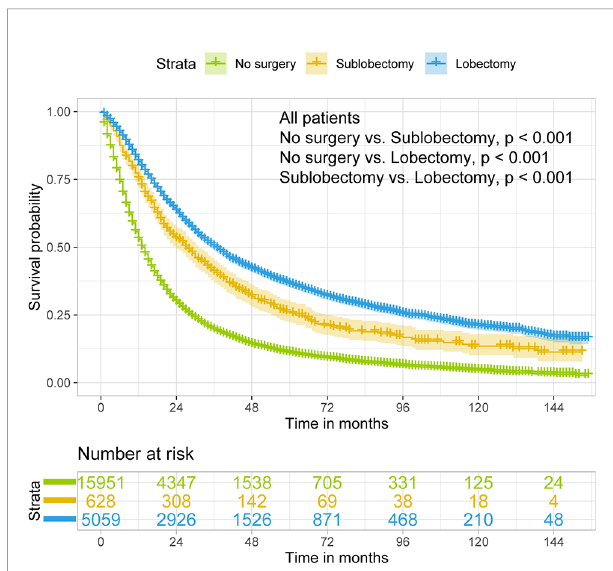
FIGURE 1 | Kaplan – Meier estimates of OS for stage IIIA/N2 NSCLC patients strati fi ed by surgery strategy. OS, overall survival; NSCLC, non-small cell lung